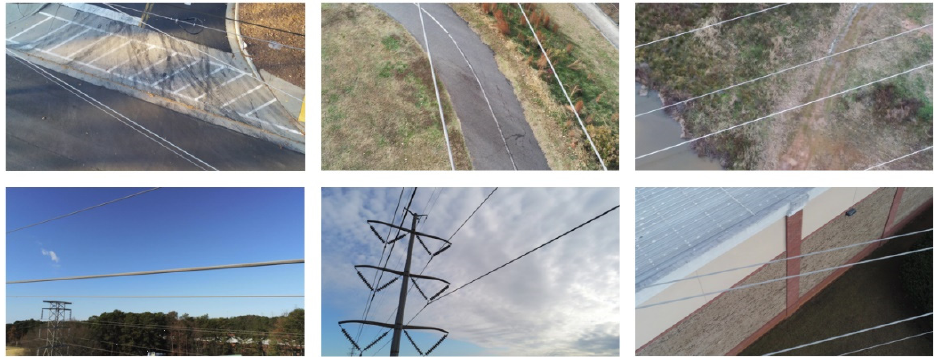
Figure 7. Sample images from the power line dataset. Power lines in different directions and back- grounds.